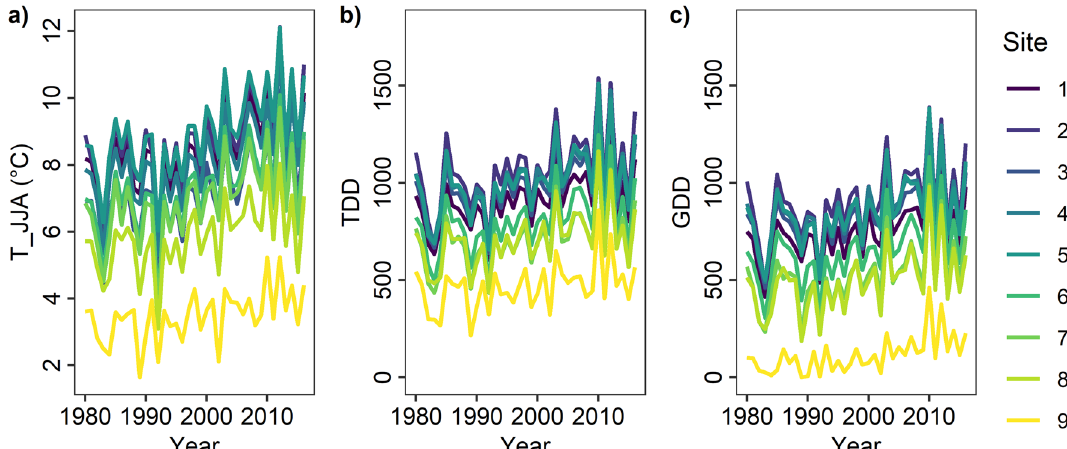
Figure 2. Climate in Nuuk Fjord region. Summer temperature (T_JJA), thawing degree days > 0 °C (TDD) and growing degree days > 5 °C (GDD) time series (period 1980–2016) of the 9 study sites based on the regional climate model MAR 3.7 38 .